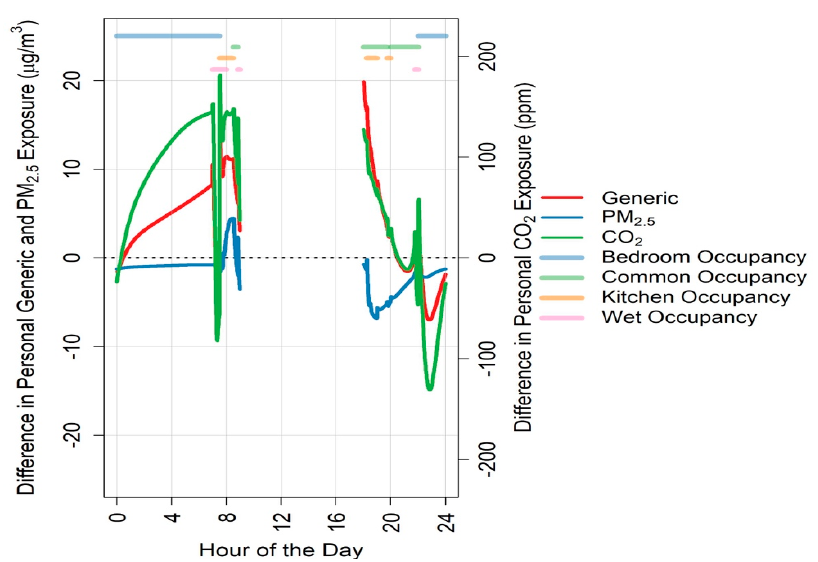
Figure 3. Differences in personal concentrations when a controlling a multi–point supply fan using the occExposure control strategy following a single occupant for 24 h who is absent from the dwelling from 9 a.m. to 5 p.m. and moving between zones during waking hours. Positive values indicate that occExposure increased personal concentrations compared with the constant multi–point supply fan baseline.